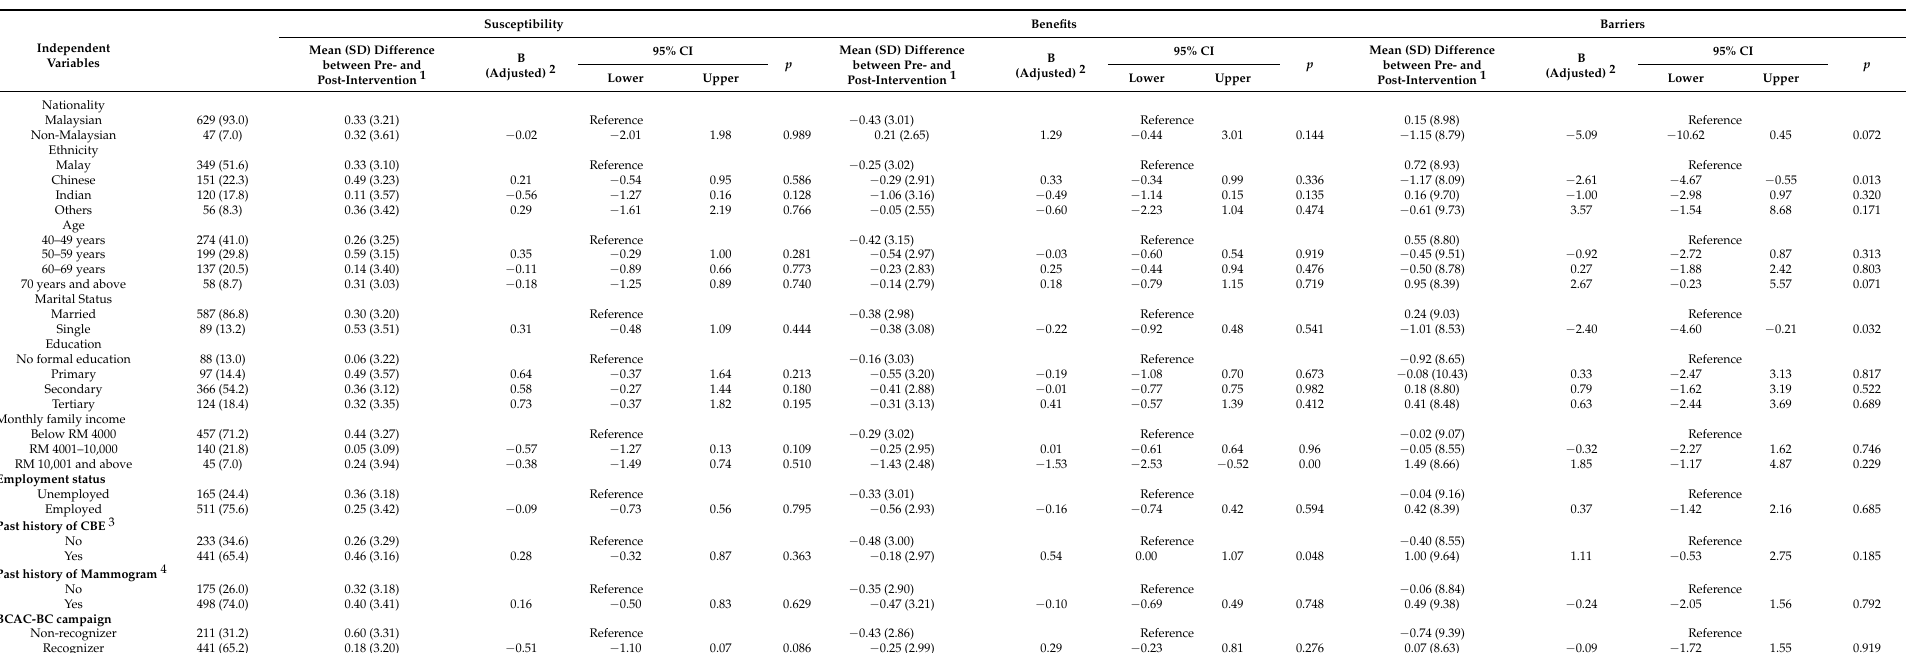
Table 4. Multiple linear regression analyses of the relationship between socio-demographic characteristics and past experience of breast cancer screening and CHBMS-BC-M ( n =